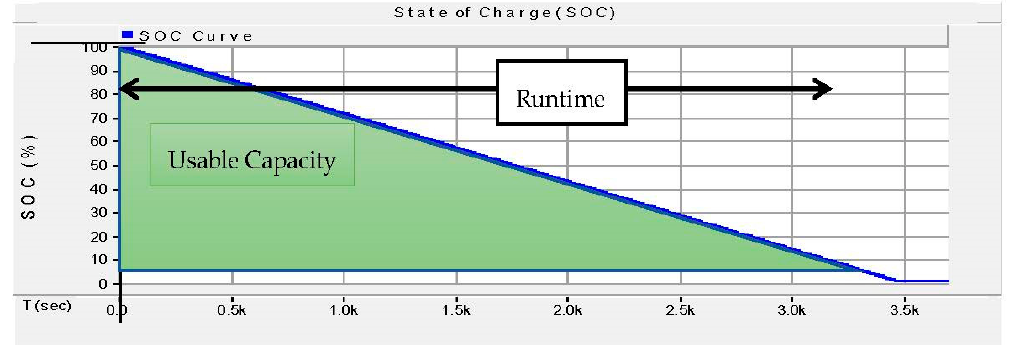
Figure 1. Demonstration of usable capacity and runtime.